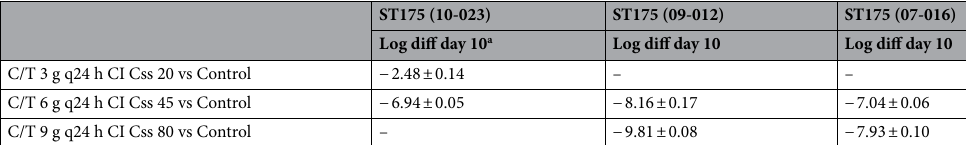
Table 1. Mean overall reduction in bacterial density (log 10 CFU/mL ± standard deviation) using alternative C/T Css regimens for each isolate. C/T ceftolozane/tazobactam, CI continuous infusion, Css steady-state concentration. a Log difference at the end of the assay for each regimen compared with the